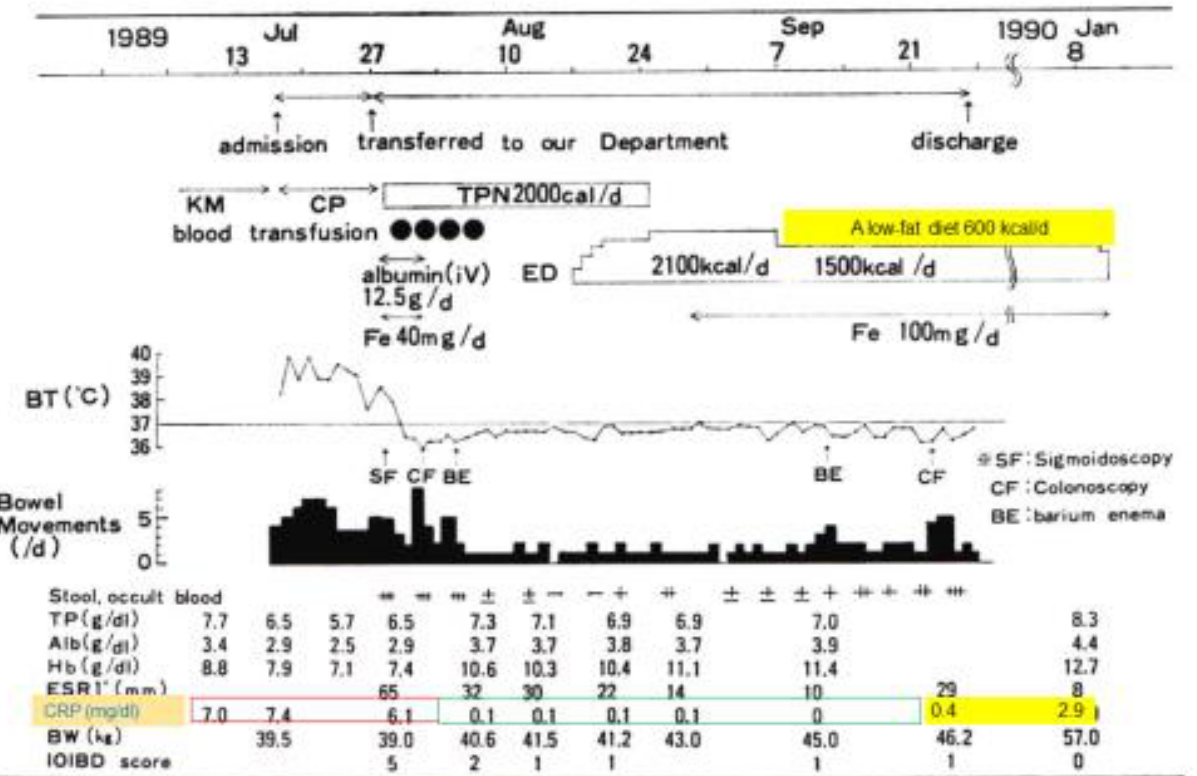
Figure 1. Clinical course of a 14-year-old girl with an initial attack of Crohn’s disease. KM, kanamycin; CP, chloramphenicol; TPN, total parenteral nutrition; ED, elemental diet; Fe, ferrum; BT, body temperature; TP, total protein; Alb, albumin; Hb, hemoglobin; ESR, erythrocyte sedimentation rate; CRP, C-reactive protein (reference ≤ 0.3 mg/dL); BW, body weight; IOIBD score, International Organization for Inflammatory Bowel Disease score.